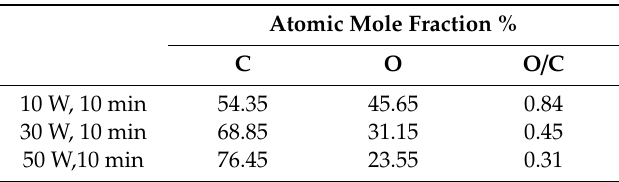
Table 3. The atomic mole fraction of O, C and O/C on Si wafer after acetic acid plasma is deposited under different conditions.